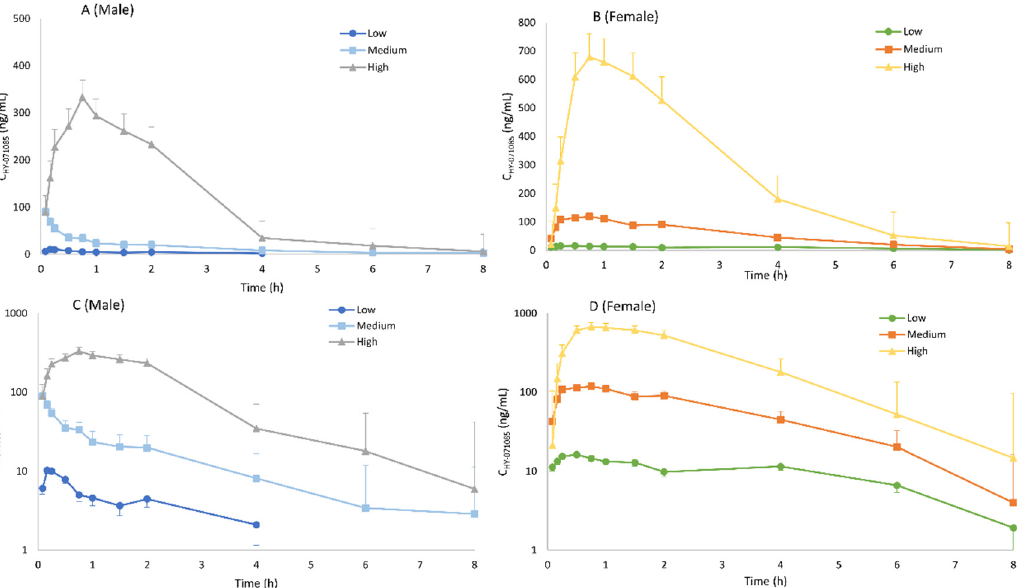
Figure 3. Comparison of the mean plasma concentration–time curve of HY-071085 after the single- dose intragastric administration of low (3.25 mg/kg), medium (6.5 mg/kg) and high (13 mg/kg) doses of HY-071085 in rats. ( A , B ) Constant coordinates; ( C , D ) semilogarithmic coordinates. Table 1. Pharmacokinetic parameters of HY-071085 after single-dose intravenous and intragastric administration, and repeated-dose intragastric administration in rats (mean ± SD).